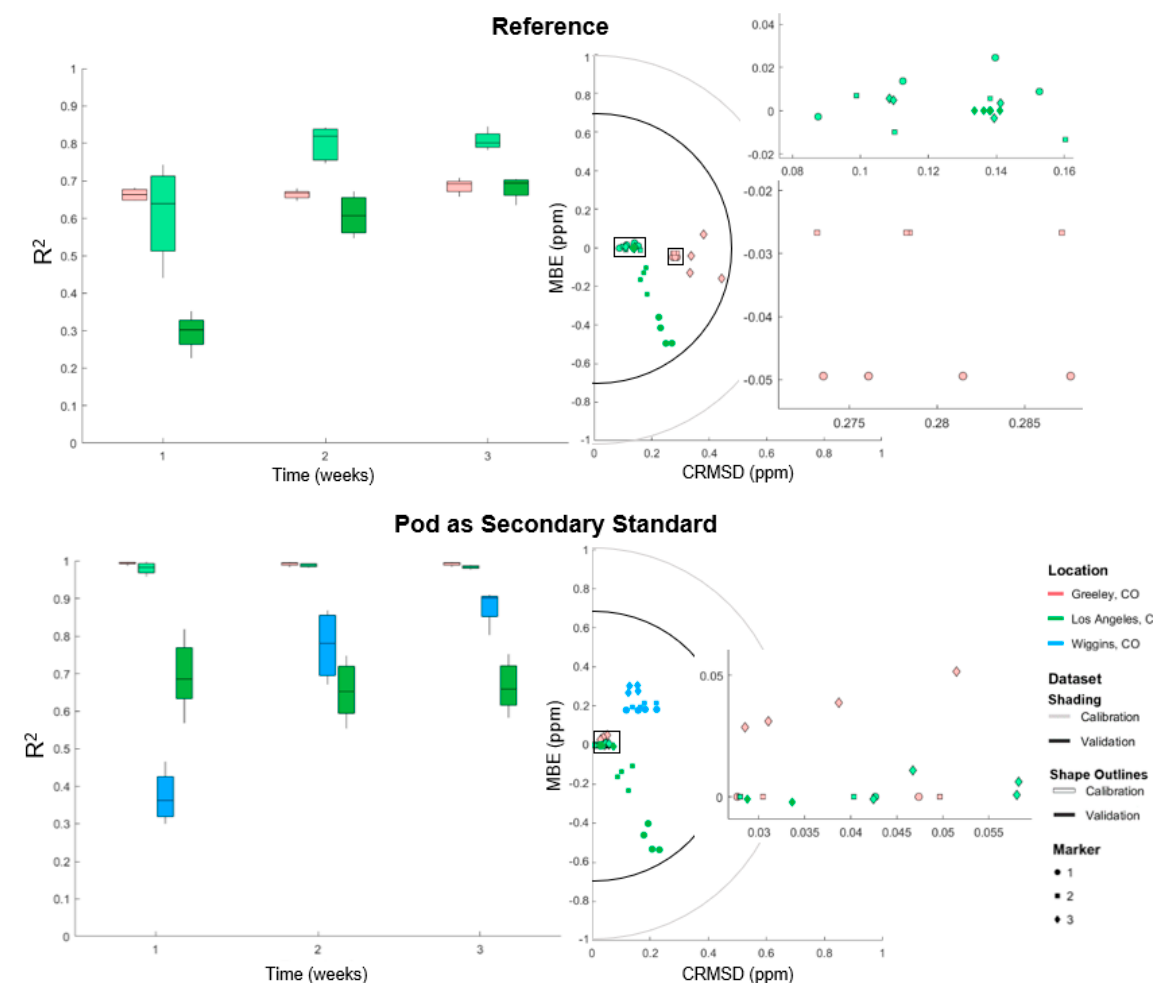
Figure 9. Methane R 2 boxplot ( left ) and MBE vs. CRMSD target plot ( right ) for duration of co-located “hop” using the one-hop approach as tabulated against a regulatory-grade reference instrument and an individually calibrated pod utilized as a secondary standard. Within each box-and whisker column, the data is as follows from left to right: Greeley calibration, Los Angeles calibration, Wiggins validation (bottom plot only), and Los Angeles